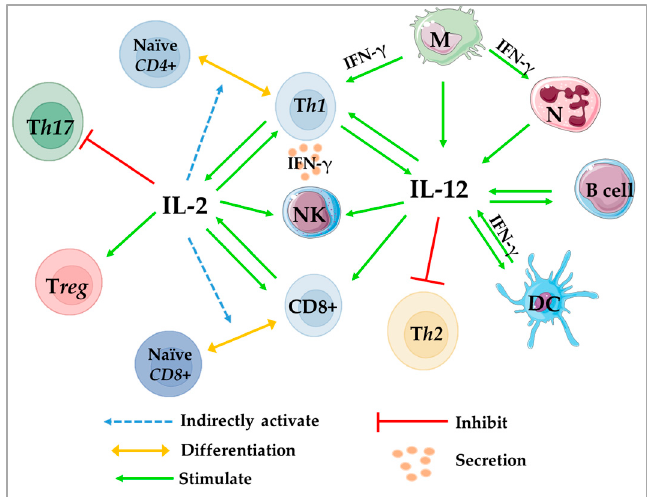
Figure 3. Reciprocal crosstalk and immunoregulation between immune cells by IL-12 and IL-2. DC: dendritic cell; IFN: interferon; IL: interleukin; M: macrophage; N: neutrophil; NK: natural killer